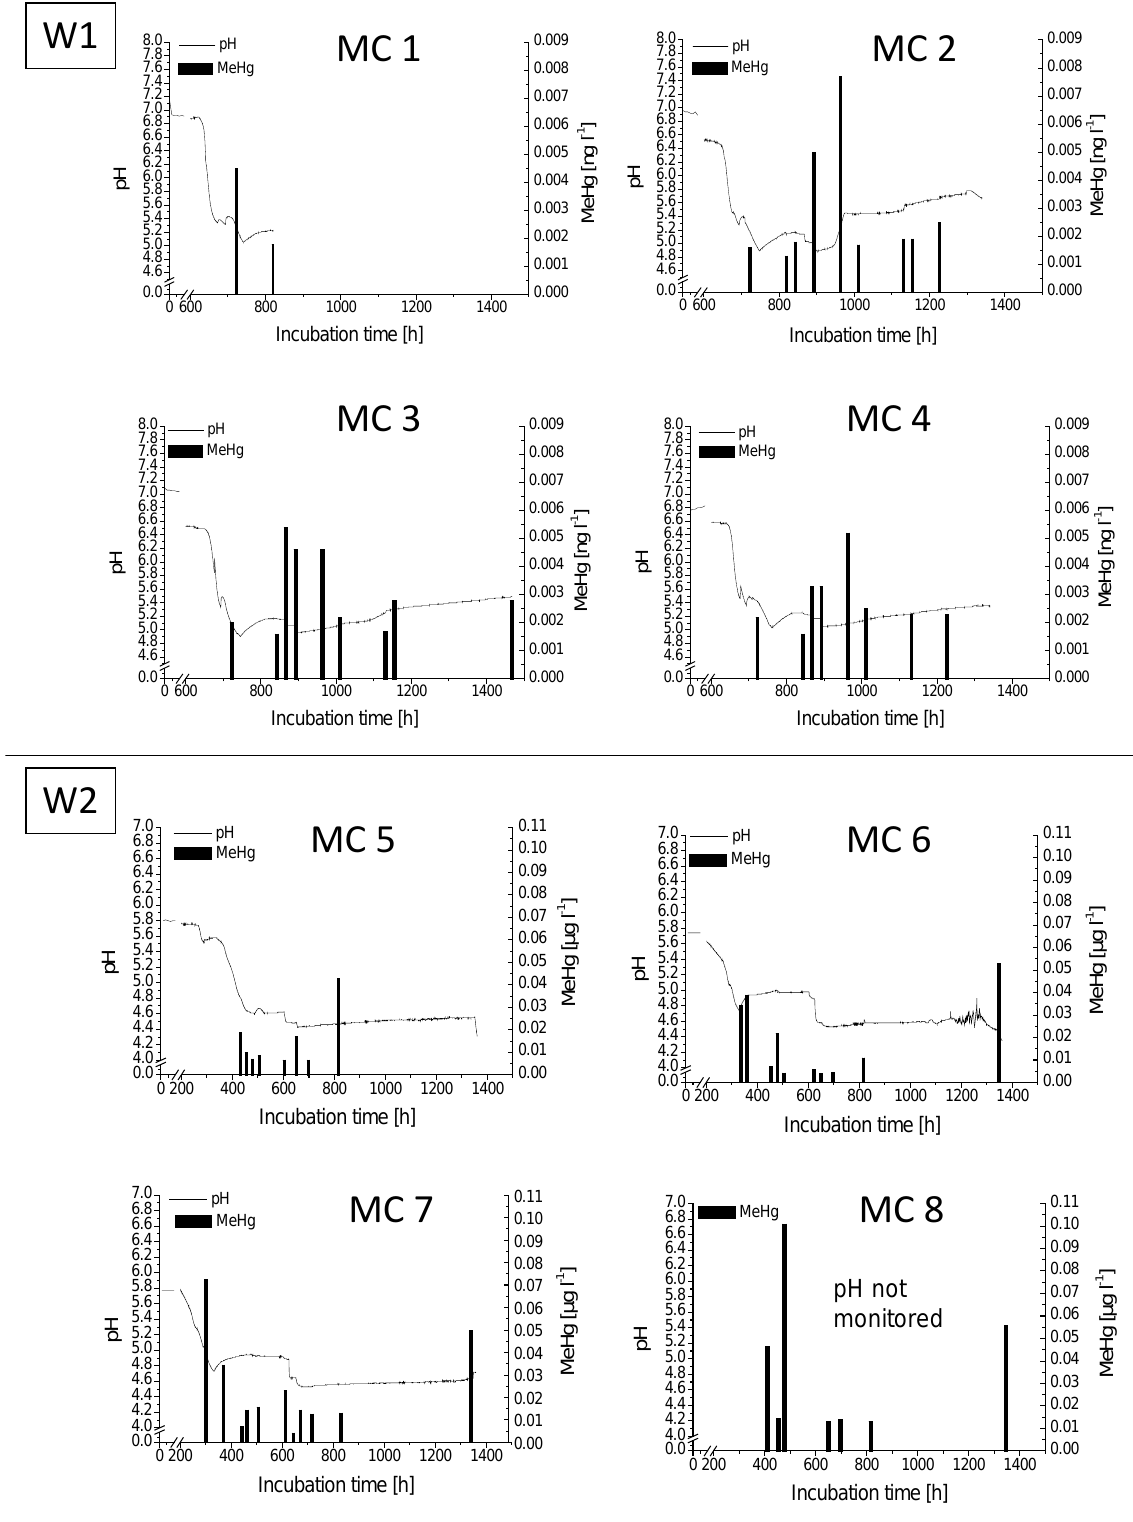
Fig. 5. Development of pH measured in the slurry every 10min and MeHg concentrations in the soluble fraction during the experiment for each microcosm (MC) (Wupper 1 = W1, Wupper 2 =